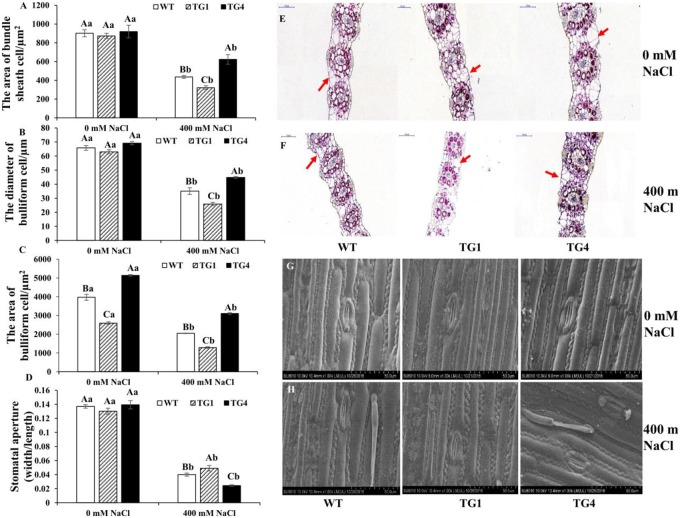
Histological analysis of the leaf in TG1, TG4 and WT plants under 0 and 400 mM NaCl.(A) The areas of bundle sheath cells, (B) the diameter of bulliform cells, (C) the areas of bulliform cells, (D) the stomatal aperture of the transgenic and and WT under 0 and 400 mM NaCl. Histological analysis in the leaf of internode 3 of TG1, TG4 and and WT under 0 (E) and 400 mM NaCl (F), Bar, 100 um. Scanning electron micrograph (SEM) imaging cells on the adaxial surface in the leaf of internode 3 of TG1, TG4 and WT under 0 (G) and 400 mM NaCl (H), Bar, 50.0 um. Value are mean ± SE (n = 3). The significance of treatment (0, 200 and 400 mM NaCl concentration) an sample type (WT and transgenic plants) was tested at the P < 0.05 level (two way ANOVA), capital letter represents the difference between WT and transgenic plants under the same salt concentration, lowercase represents the difference of WT or transgenic plants under 0 and 400 mM NaCl concentration.